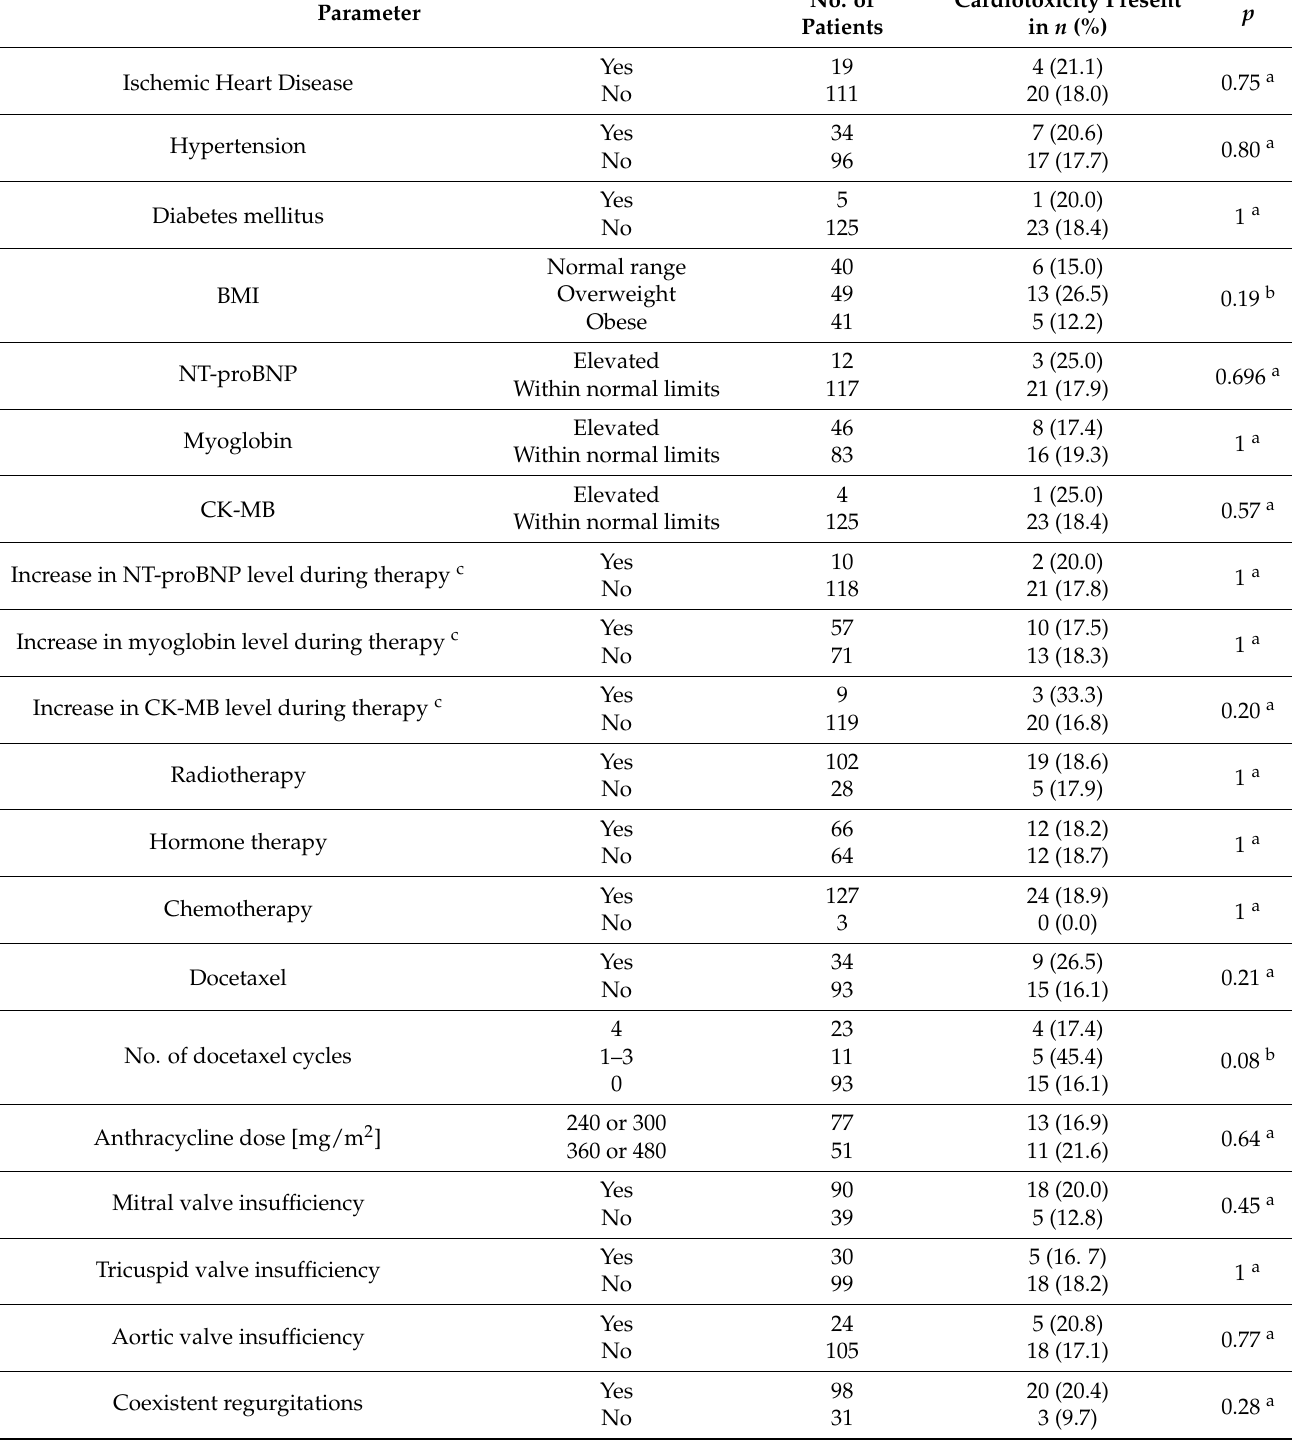
Table 3. Relation between clinical and biochemical parameters and TIC.